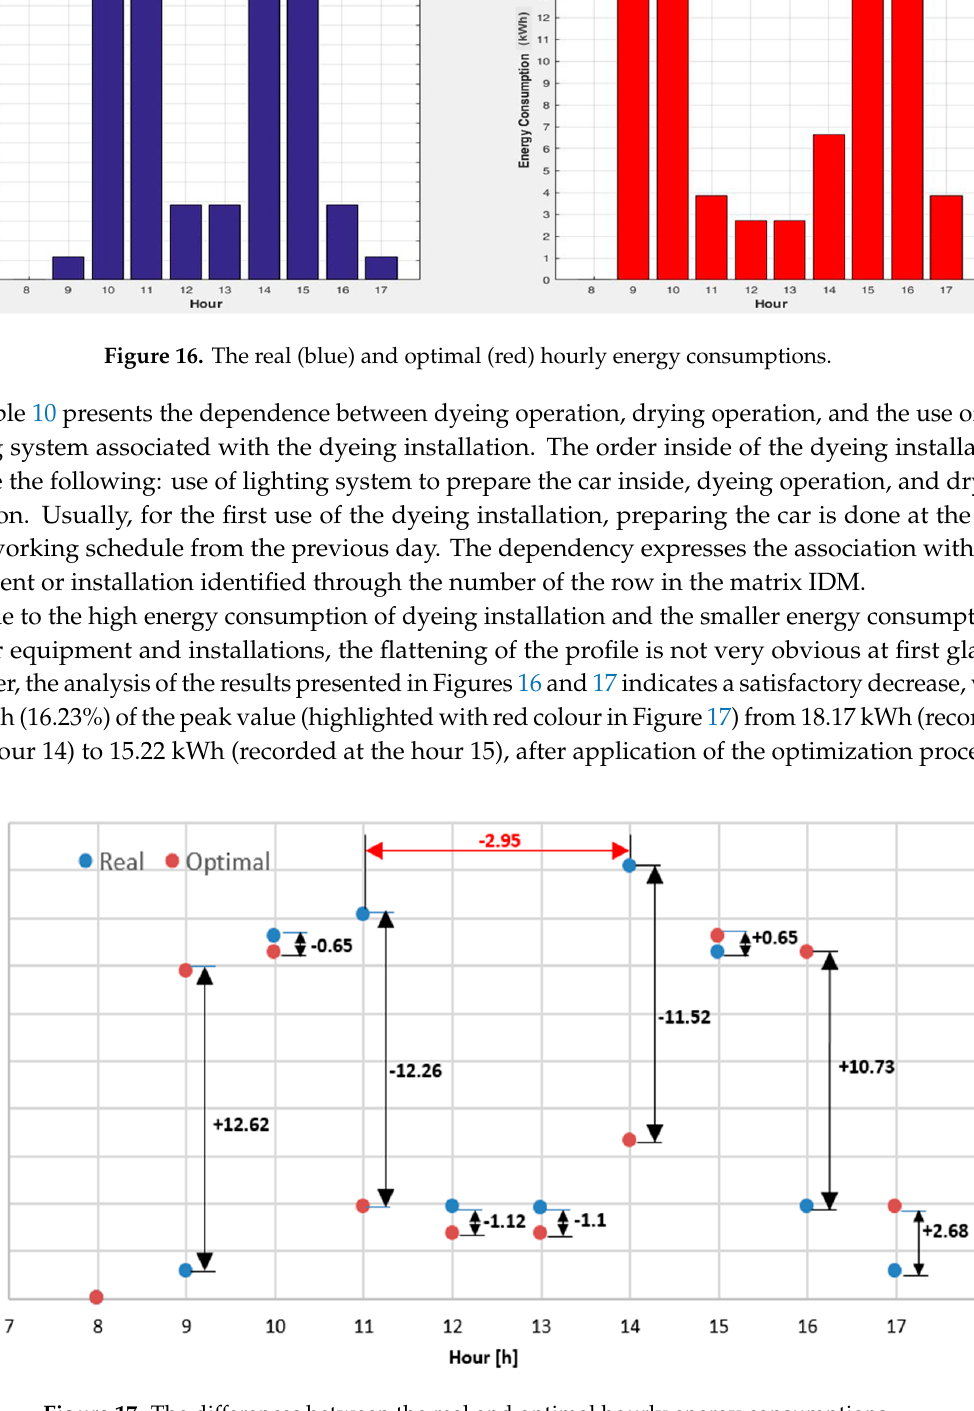
Figure 17. The differences between the real and optimal hourly energy consumptions. Figure 17. The di ff erences between the real and optimal hourly energy